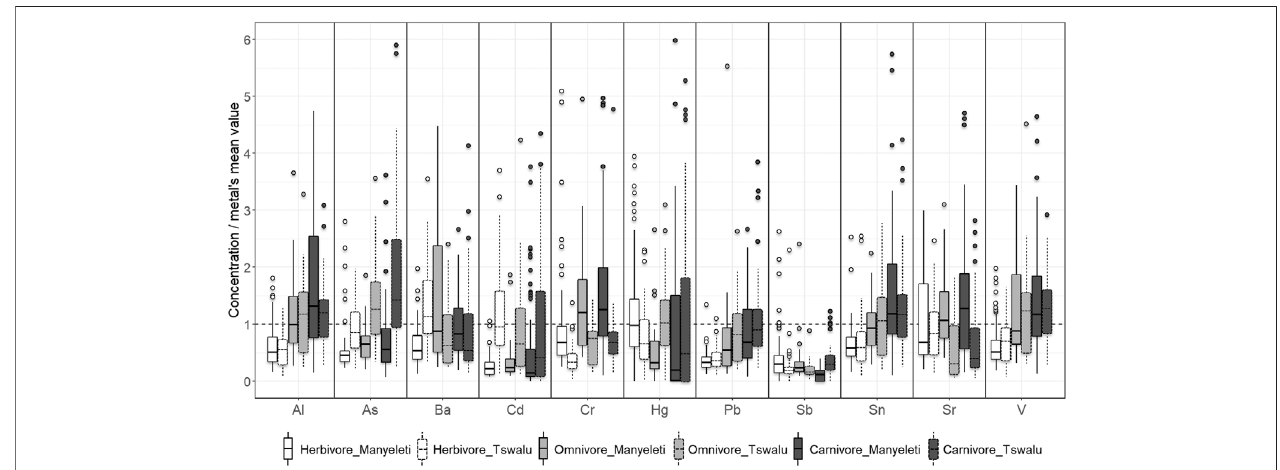
FIGURE 3 | Differences in measured potentially toxic element concentrations between sites (MNR: solid borders, TKR: dashed borders) in herbivorous (white), omnivorous (light grey), and carnivorous (dark grey) mammals relative to the mean for both sites (dashed line). Dark lines within boxes represent median values; the box represents the upper (3rd) and lower (1st) quartiles. Whiskers above and below the box represent minimum and maximum values excluding outliers. Points represent outliers. Concentrations are relativized and given as microgram per kilogram (µg/kg) faecal dry mass